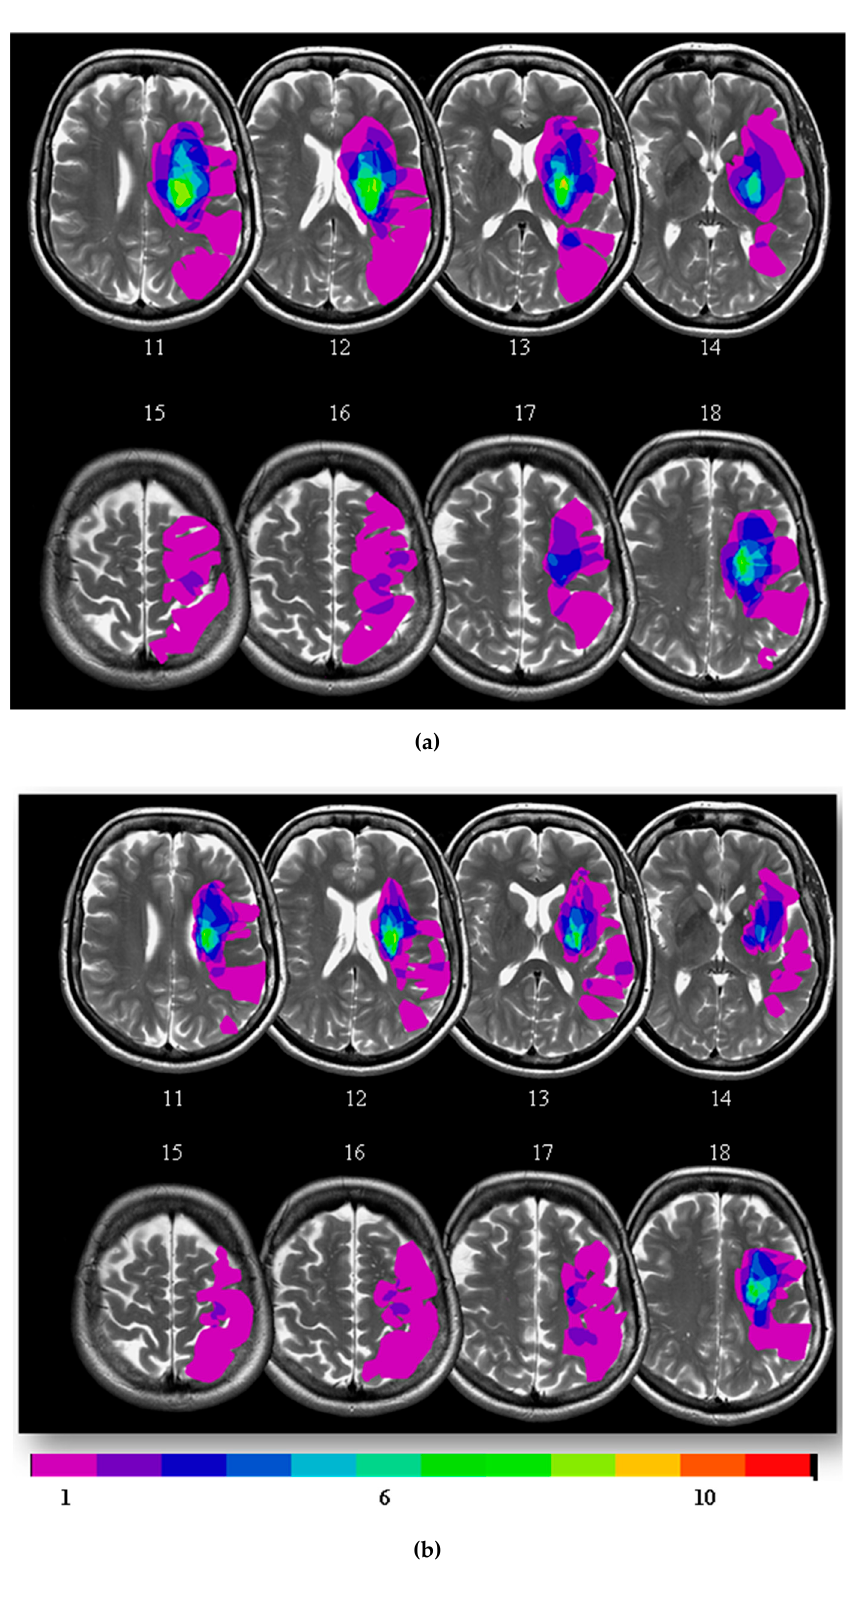
Figure 1. T2 weighted lesion overlay maps of 15 stroke patients at baseline ( a ) and 12 weeks ( b ). For patients with right-sided strokes, images were flipped before delineating the lesions.